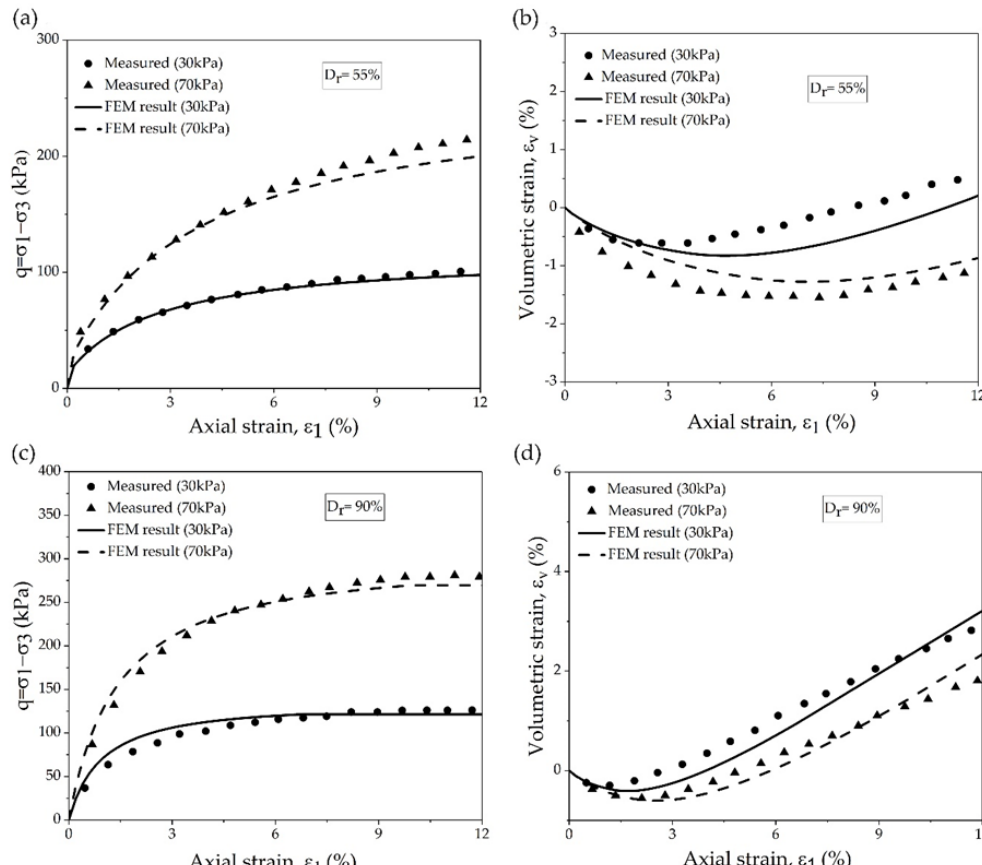
Figure 6. The behavior of the foundation and the backfill soil and the calibration results under triaxial tests: ( a ) stress-strain relationship at 55% relative density; ( b ) volumetric-axial strain relationship at 55% relative density; ( c ) stress-strain relationship at 90% relative density; ( d ) volumetric-axial strain relationship at 90% relative density